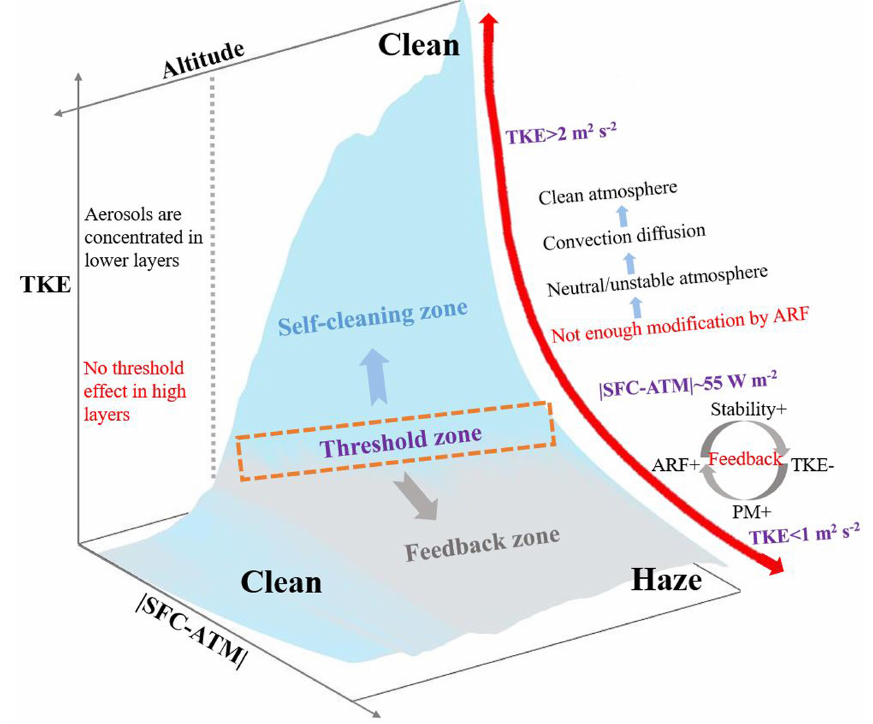
Figure 8. Schematic diagram of the interaction between the aerosol radiative forcing (ARF) and boundary layer structure ( | SFC − ATM | : the mean absolute difference in the aerosol radiative forcing at the surface and interior of the atmospheric column; TKE: the mean turbulence kinetic